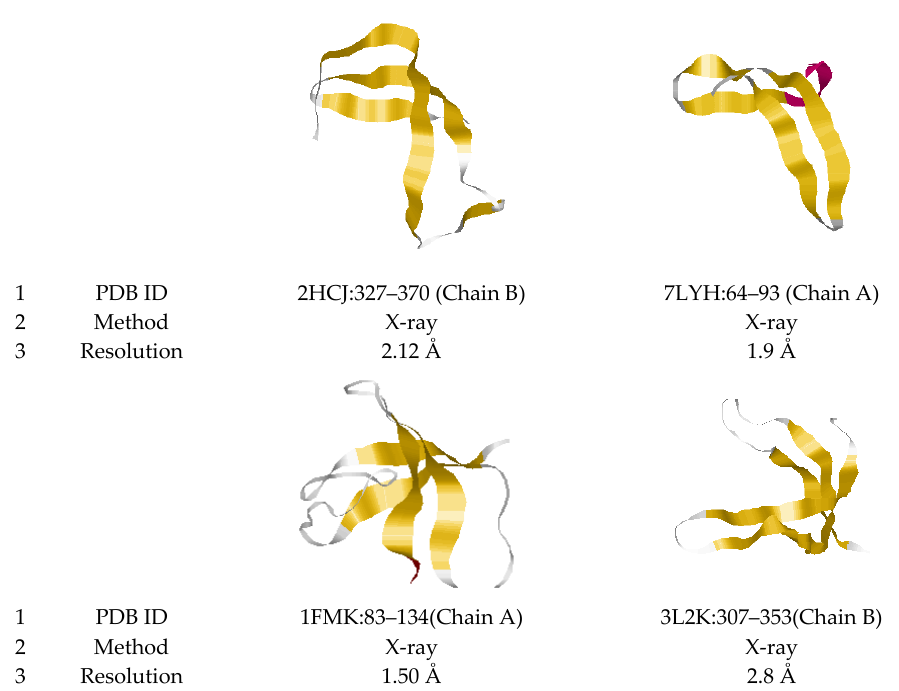
Figure 1. Ribbon model representations of 3 β‐ corners. Examples of the tape model of the motif are presented. 3 β‐ corners were extracted from elongation factor Tu 1 (2HCJ, E. coli ), replicase polyprotein 1ab (7LYH, Coronavirus 2 ), tyrosine-protein kinase c-SRC (1FMK, Homo sapiens ), enoyl-ACP reductase (1NHG, Plasmodium falciparum ), EhpF (3L2K, Pantoea agglomerans ) and peptidyl-prolyl cis-trans isomerase A (3K0M, Homo sapiens ) proteins. The coordinates of the 3 β -corner in each protein (1), the experimental method for obtaining the structure (2) and the analysis resolution (less than 2 Å) are indicated (3). Secondary structure elements are highlighted by color: β‐ stands (yellow), helix (red) and coil (white).